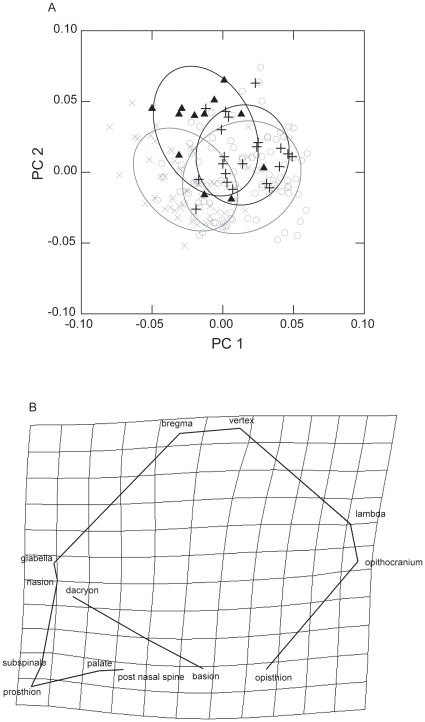
Differentiation according with PCA.(A) Samples distribution according with PC1 vs. PC2. Ellipses represent the 95% confidence interval of distributions for each sample. X: Eastern non-pygmies; O: Western non-pygmies; Δ: Eastern pygmies; +: Western pygmies. B) Transformation grids on PC1 in lateral view. Eastern groups were considered the reference and western groups, the target. Basilar and frontal views do not represent any important variation.